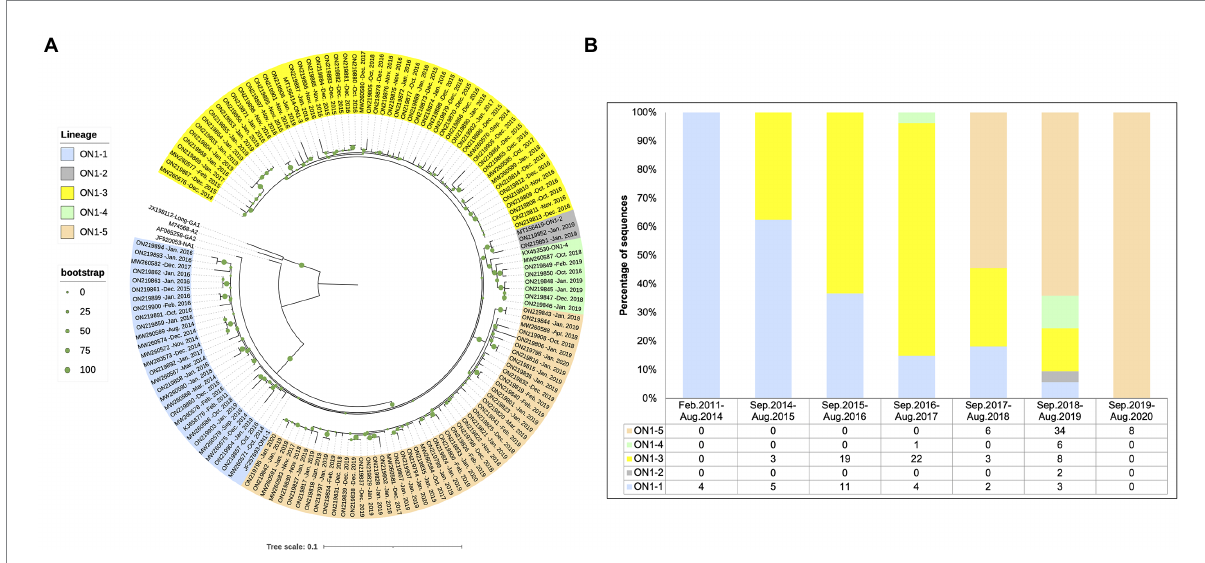
FIGURE 3 Phylogenetic analysis of the G gene sequences from RSV-A strains circulating in Shanghai, February 2011–March 2020. (A) RSV-A G sequences obtained from RSV-A-positive samples in this work, derived from archived RSV-A-positive samples collected in previous years, and sequences from strains isolated in Shanghai available from GenBank were used to generate a phylogenetic tree using RAxML with 1,000 independent bootstrap searches along with reference strain sequences. (B) Sequences analyzed in (A) were grouped according to isolation date into epidemic seasons as indicated, and circulating genotypes and lineages were tabulated and plotted for each